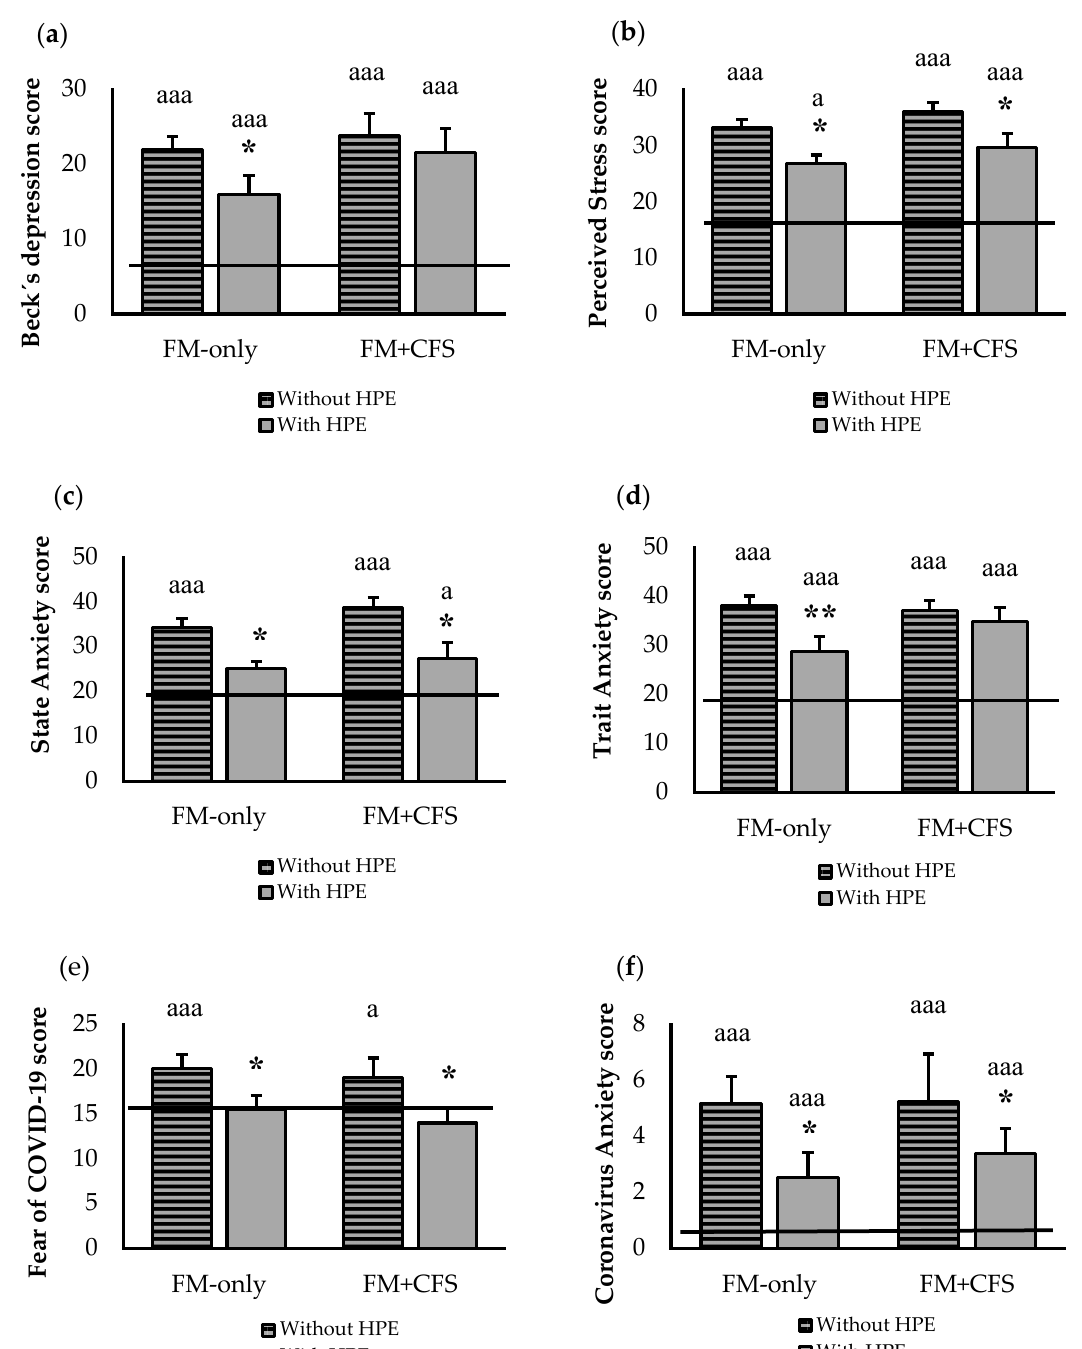
Figure 3. Effect of Habitual Physical Exercise (HPE) in patients diagnosed only with FM (FM-only, n = 38: 27 without HPE and 11 with HPE) and codiagnosed with CFS (FM + CFS, n = 32: 15 without HPE and 17 with HPE), on psychological status and mental health: perceived levels of ( a ) depression; ( b ) stress; ( c ) state anxiety; ( d ) trait anxiety; ( e ) fear of COVID-19 and ( f ) coronavirus anxiety. Horizontal line represents values obtained in the age-matched reference group of “healthy” women without FM. Columns represent the mean ± SEM of each experimental group with or without reported HPE. FM: Fibromyalgia, CFS: Chronic Fatigue Syndrome. * p < 0.05, ** p < 0.01 with respect to the corresponding group without HPE. a p < 0.05, aaa p < 0.001 with respect to reference group. “Without HPE”: participants non reporting HPE; “With HPE”: participants reporting